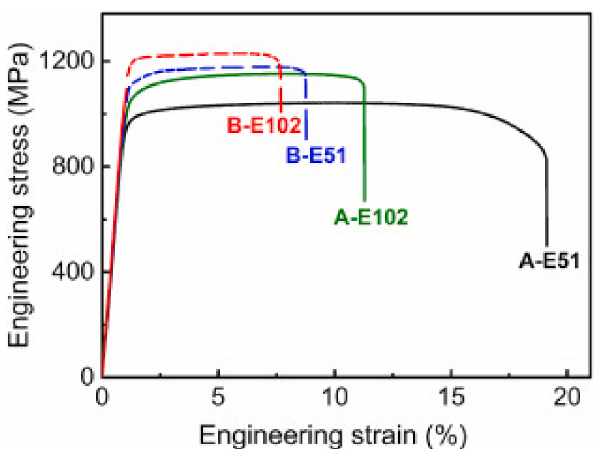
Figure 3. Engineering stress–strain plot for EBM-built Ti-55511 at different process parameters. A-E51: electron energy density 51 J/mm 3 and substrate temperature 650 ◦ C; A-E102: electron energy density 102 J/mm 3 and substrate temperature 650 ◦ C; B-E51: electron energy density 51 J/mm 3 and substrate temperature 750 ◦ C; B-E102: electron energy density 102 J/mm 3 and substrate temperature 750 ◦ C. Reprinted with permission from ref. [60]. Copyright 2021